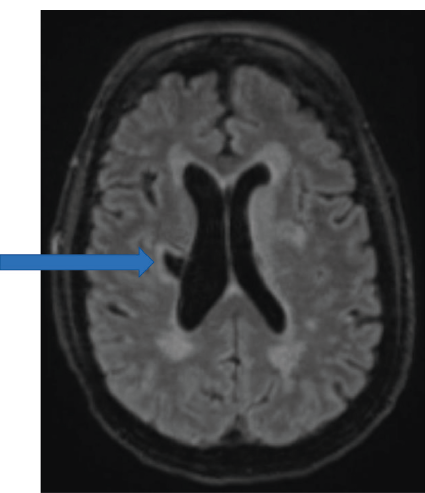
Figure 1: Initial MRI T2 FLAIR delineating chronic right corona radiata and putamen infarcts with ex-vacuo dilation of the right lateral ventricle.